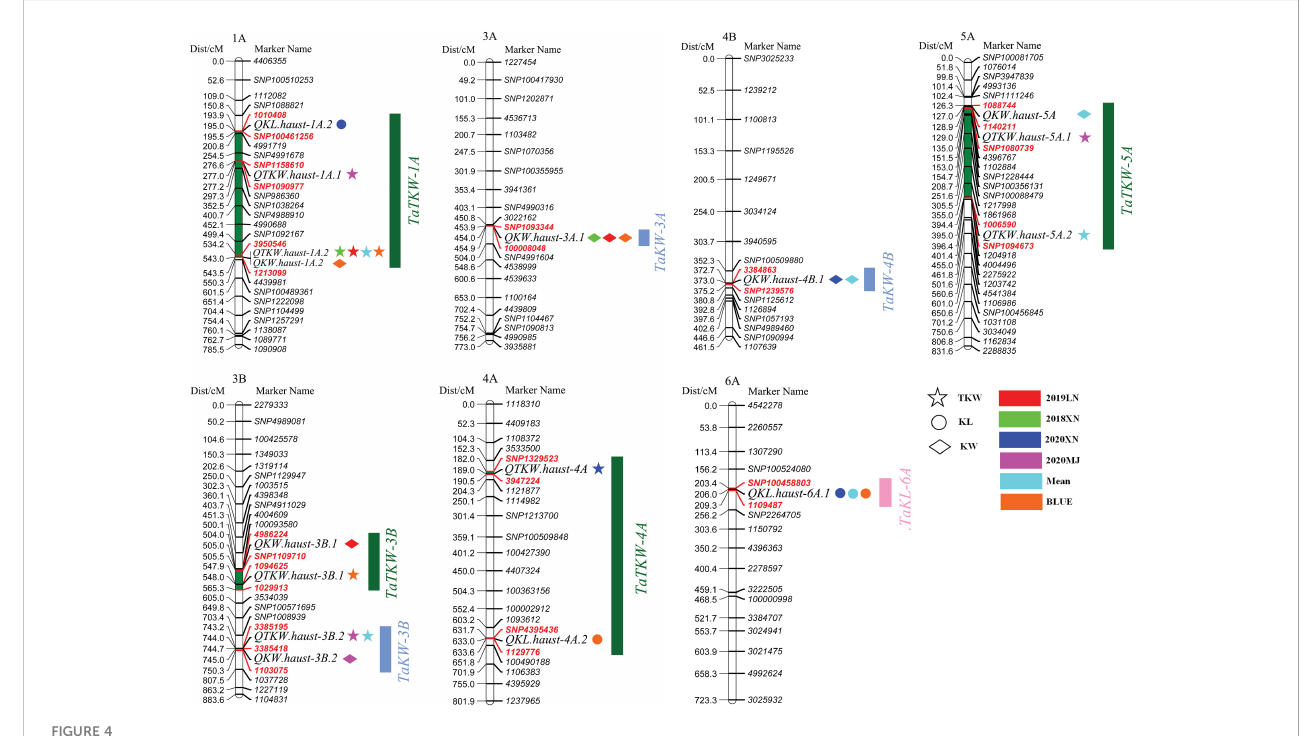
FIGURE 4 Locations of QTLs of the stable QTL clusters.